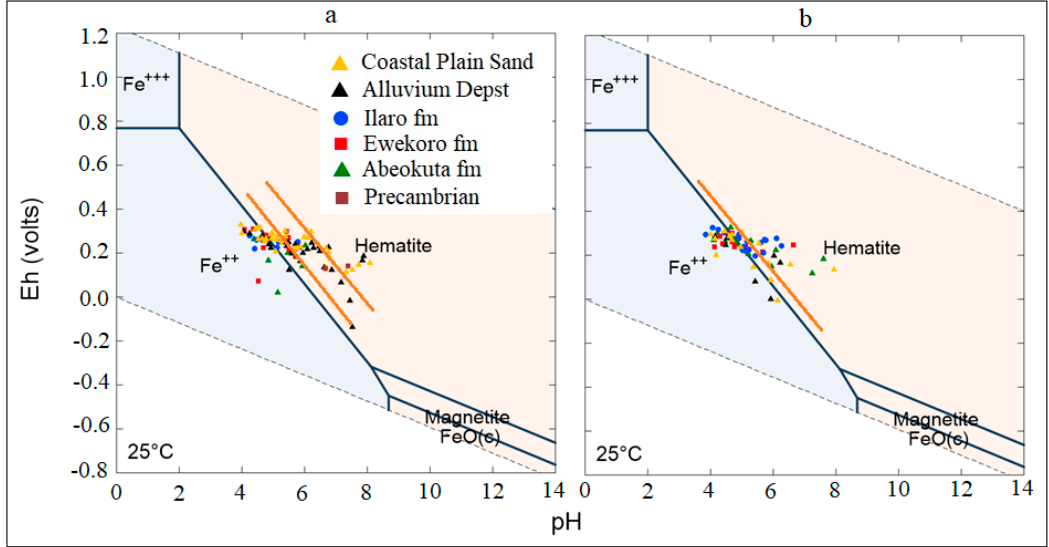
Water 2020 , 12 , x FOR PEER REVIEW Figure 13. Eh-pH diagram for Iron species in the sampled groundwater ( a ) Wet season; ( b ) dry season.